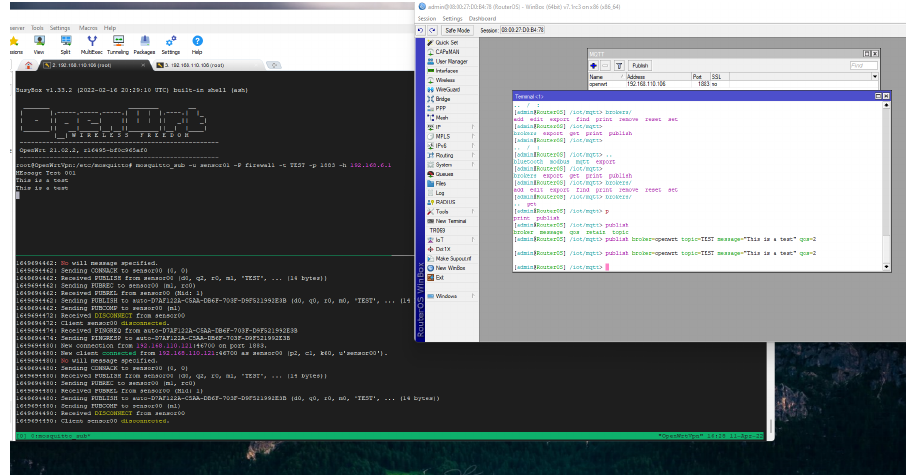
Figure 1. A publish/subscribe scenario from Mikrotik to OpenWRT MQTT